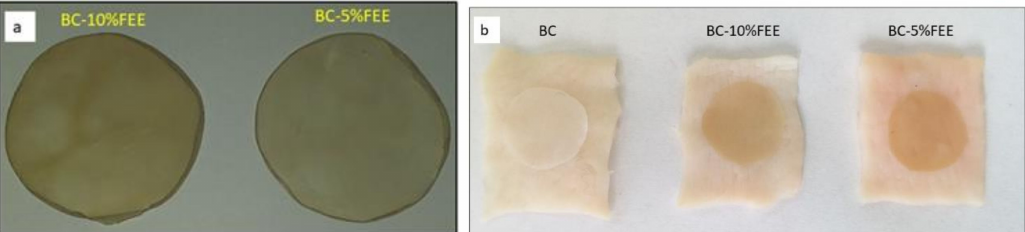
Figure 3. The BC-10%FEE and BC-5%FEE dry membranes ( a ), the all membranes before mounting in the Franz diffusion cell ( b